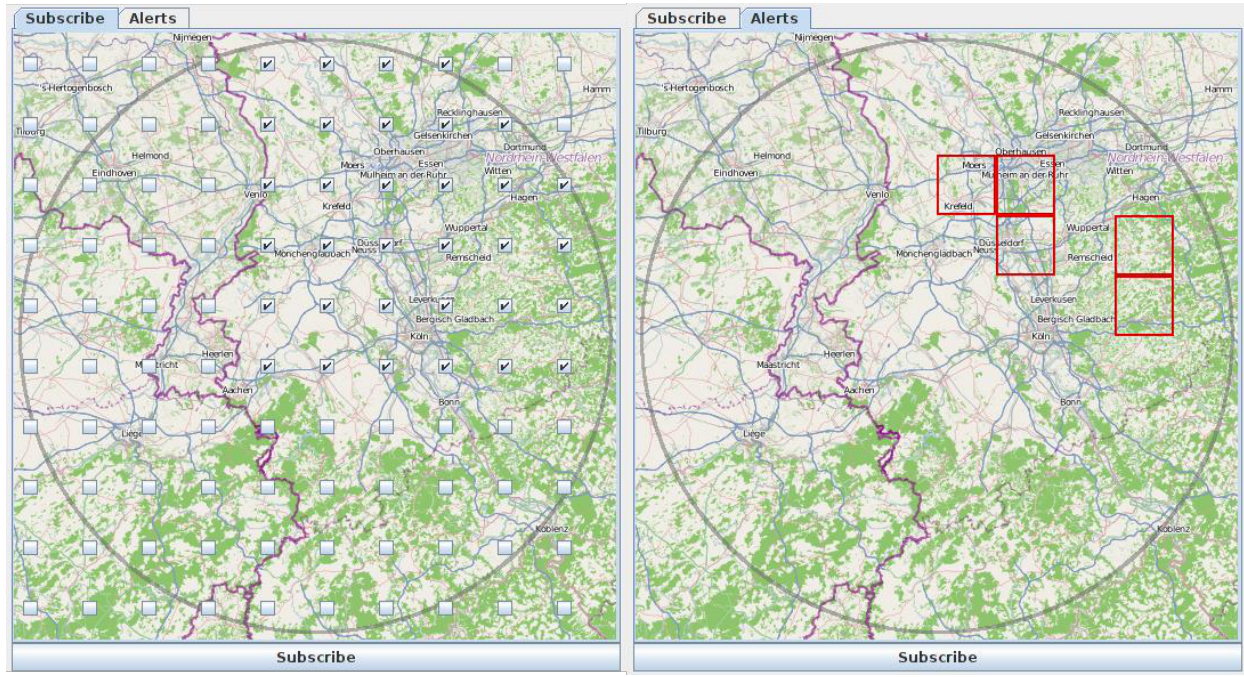
Figure 12. Graphical user interface (GUI) of the heavy precipitation detection